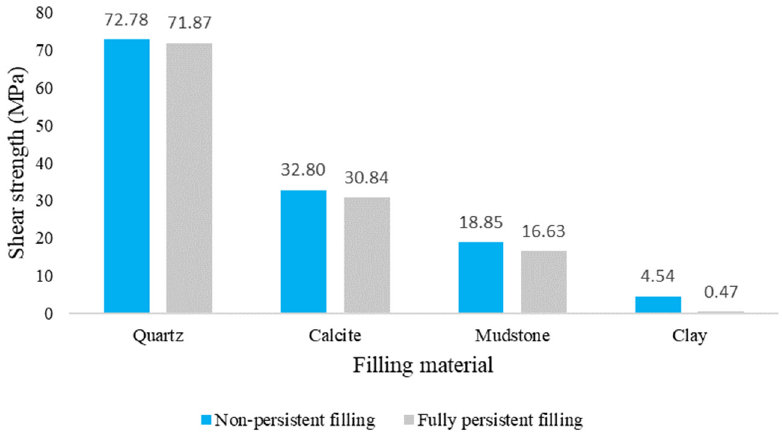
Figure 19. Peak shear strength of rock specimens with fully persistent filling and having 10% rock bridge.